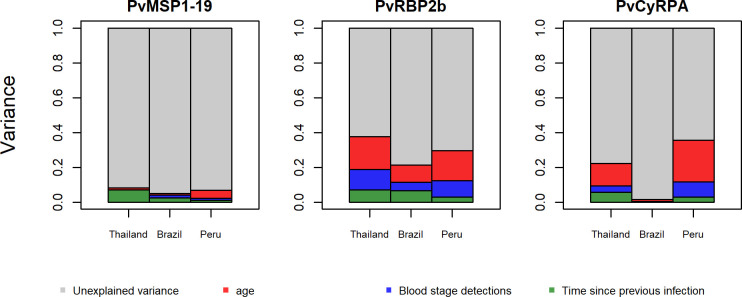
Contribution of recent and lifetime exposure to the variance of antibody responses to PvMSP119, PvRBP2b and PvCyRPA across the study sites.Panels represent the variance estimated for each marker. The area of each colored bar is proportional to the variance explained by known and unknown factors. Red bars: variance explained by individual’s age. Blue bars: variance explained by number of blood stage detections by qPCR during 13 months of follow up. Green bars: variance explained by time since previous infection (days). Grey bars: unexplained variance.